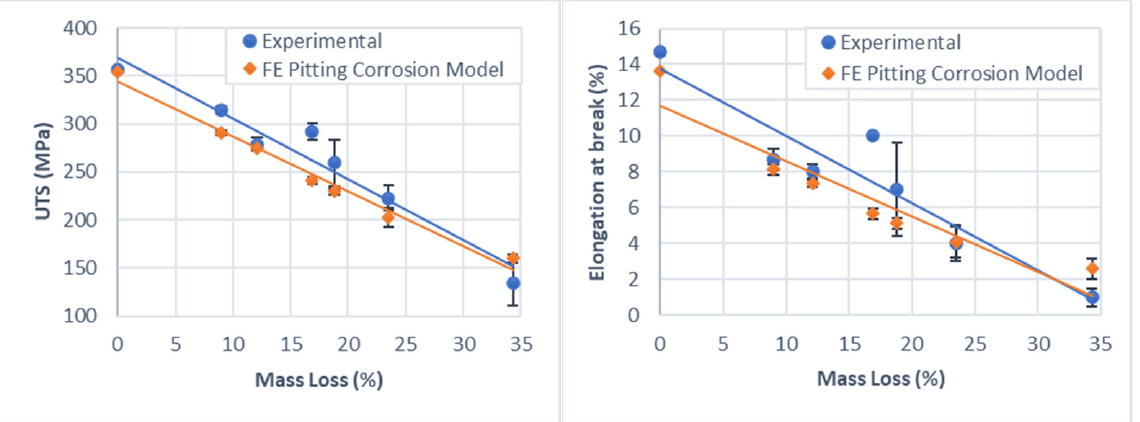
Figure 11. Reduction in material UTS (MPA) and elongation at break (%) due to degradation, based on the results of experiment 2. The FE pitting corrosion model results are also shown as comparison. Error bars represent a single standard deviation from the mean (n = 3).